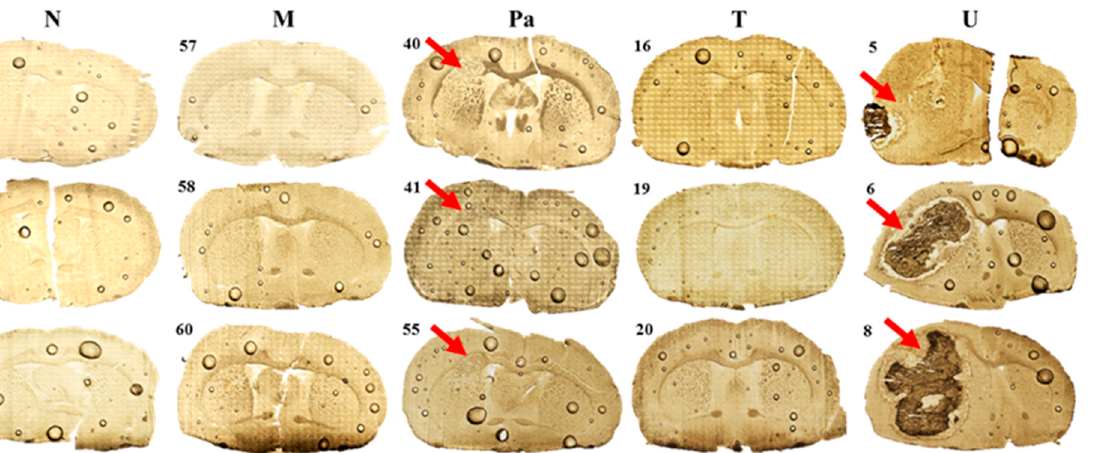
Figure 2. Microscopic images of tissue slices taken from the place of the implantation from 3 representative animals of each examined experimental group (N—normal rats; M—animals receiving DMEM; Pa, T and U—animals implanted with GBM cells taken from patient and T98g or U87mg cell lines, respectively). Red arrows indicate tumor bulk developed after the implantation of glioma cells.